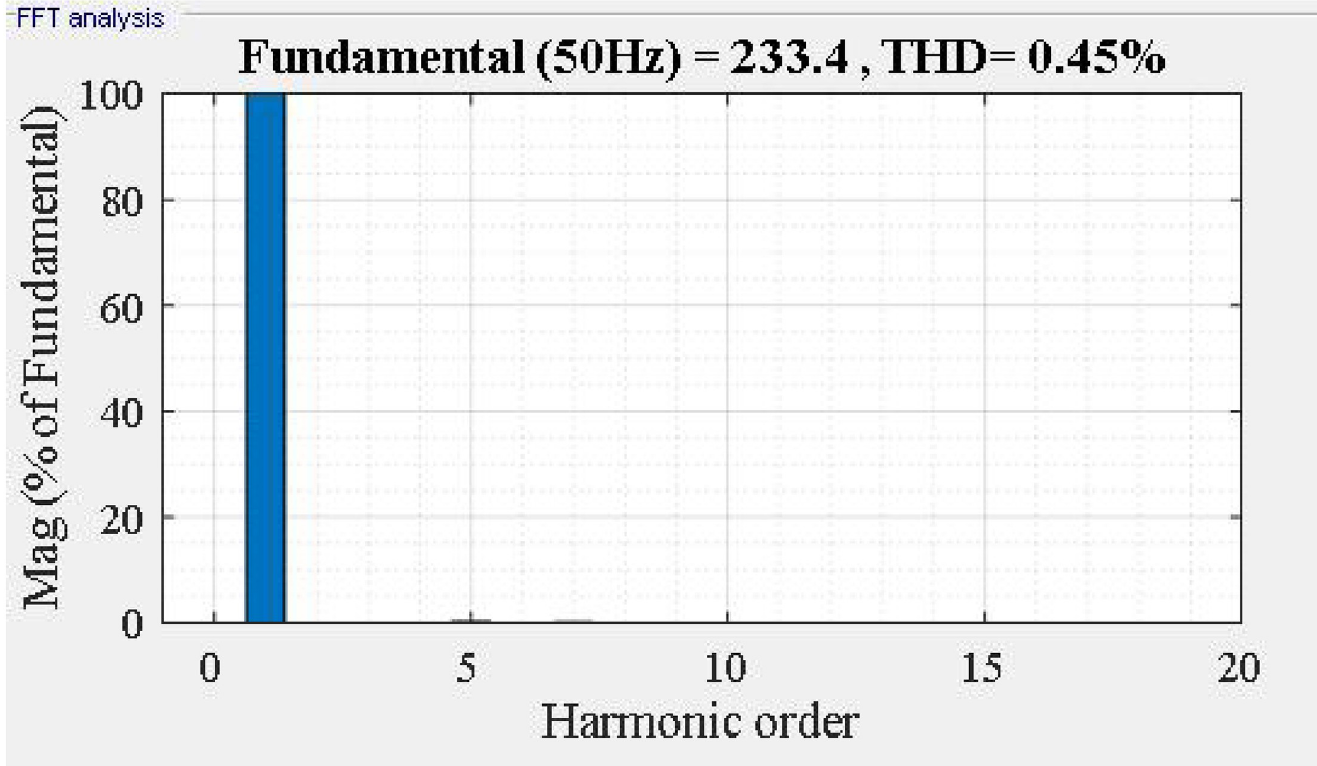
Fig 10. Frequency spectrum of supply current isa with Jaya algorithm.